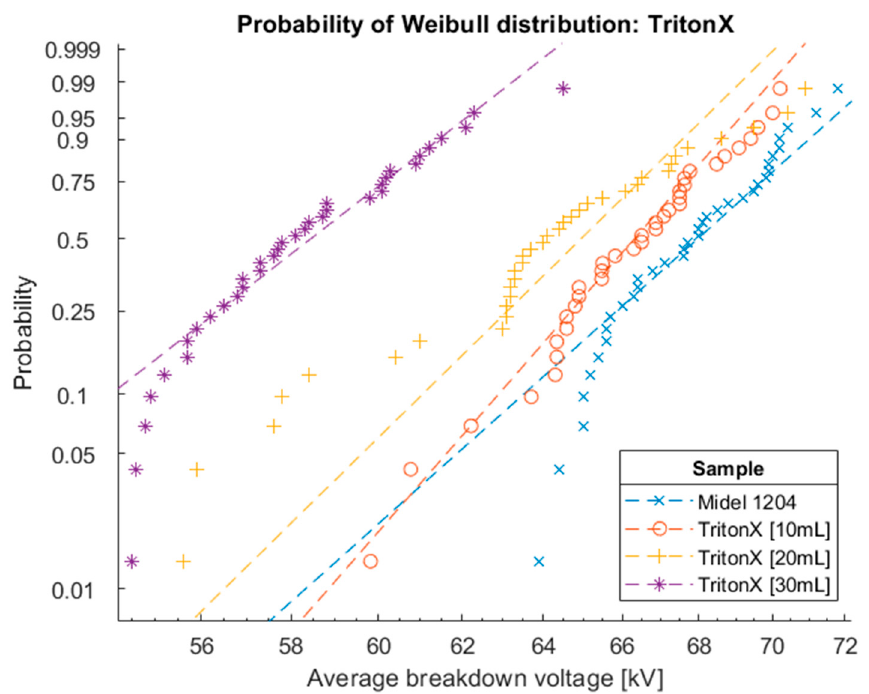
Figure 15. Cumulation distribution functions for Weibull distribution of oil Midel 1204 with different concentrations of surfactant Triton X.